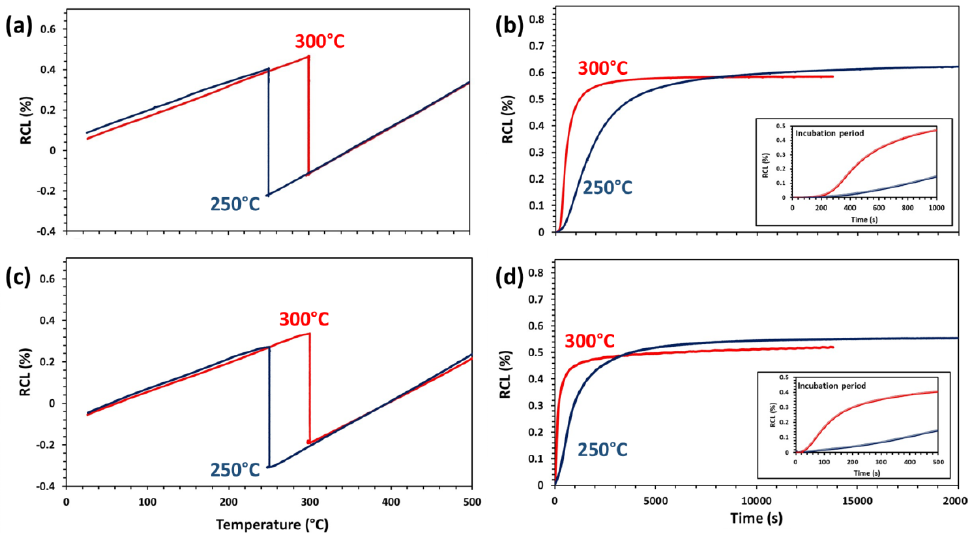
Figure 4. For the case steel (0.76 C wt.%), relative change in length (RCL) curves as a function of temperature and time for the different T iso -t iso ( a ) and ( b ) for T γ = 900 °C and ( c ) and ( d ) T γ = 830 °C.